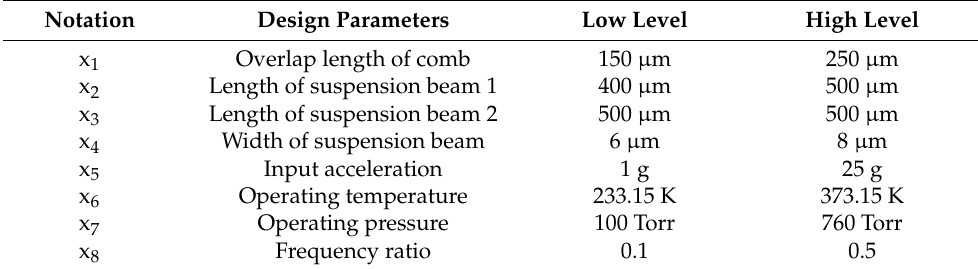
Table 1. Design parameters for the MEMS device.